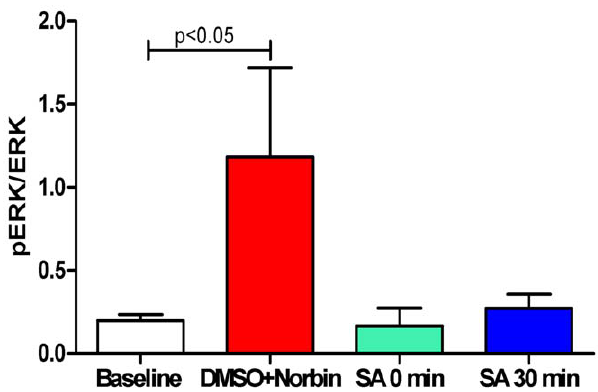
Figure 4. Salvinorin A administration blocked the elevated CSF ERK activity observed 1 h after HI. The ration of pERK/ERK at 1 hour after HI in the control groups (n=10, DMSO and nor-BIN groups) increased significantly compared with the baseline. The baseline for all the groups are pulled together (n=20) and the data from DMSO and nor-BIN groups were pulled together and presented as DMSO + Norbin (n=10) to increase the power of the statistical analysis because of some large variances were observed. The elevated ERK activities were abolished in the groups with salvinorin A administrated immediately (n=5) or 30 min (n=5) after HI. Norbin: norbinaltorphimine; SA: Salvinorin A.